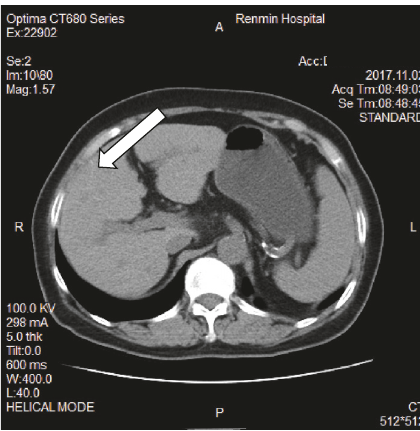
Figure 6: CT scan showing thickened intestinal wall and calcifica- tion.